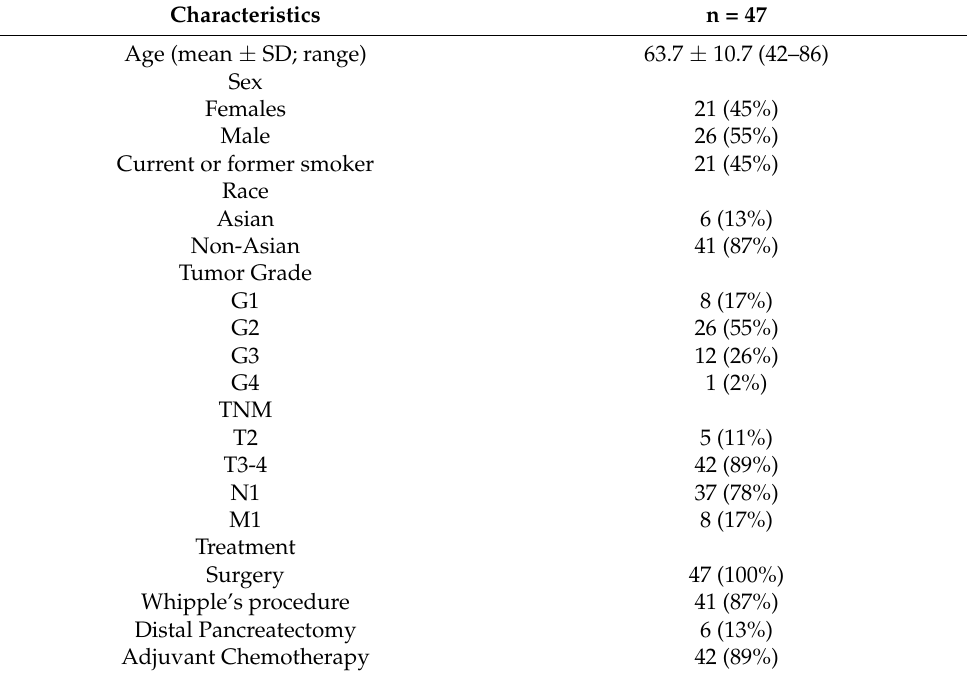
Table 1. Demographic data of the study cohort.